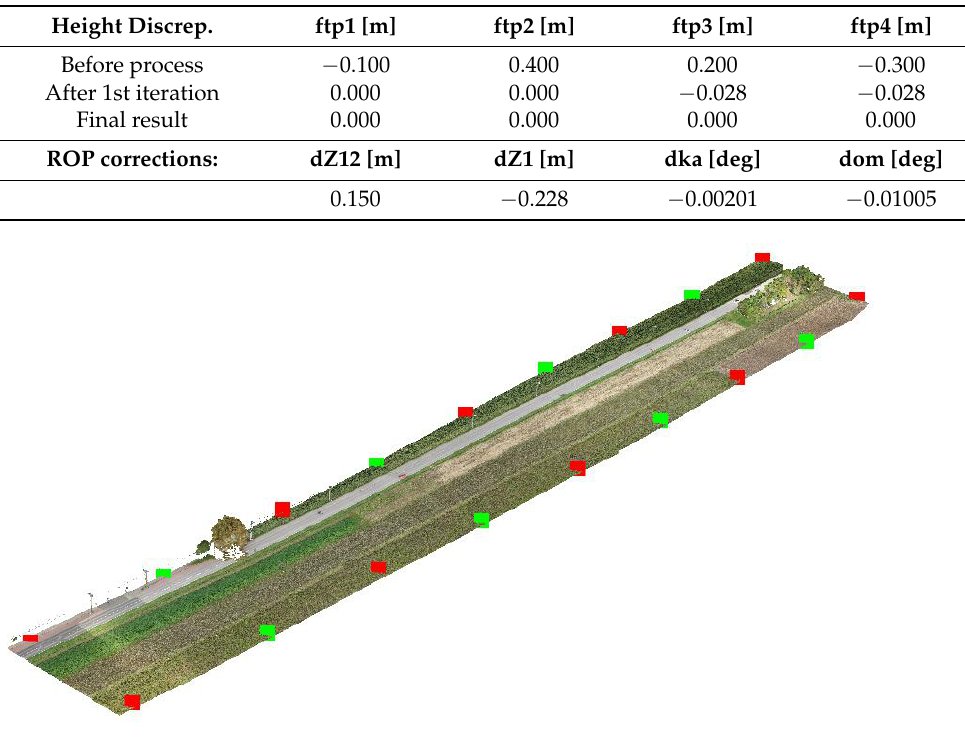
Figure 7. Strip of UAV lidar data with ten GCPs (red) and eight check points (green). The data were corrected in four segments, and the results were analogical to the results of the synthetic data: the differences on each GCP were 0.000 m after the third iteration (Table 2), and the ROP corrections were calculated and applied